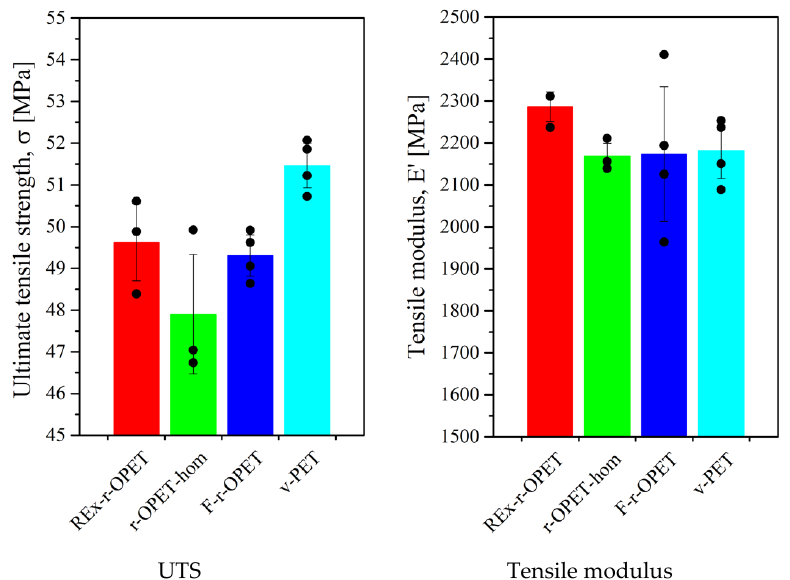
Figure 5. Ultimate Tensile Strength and tensile modulus properties of PET specimens, extracted from